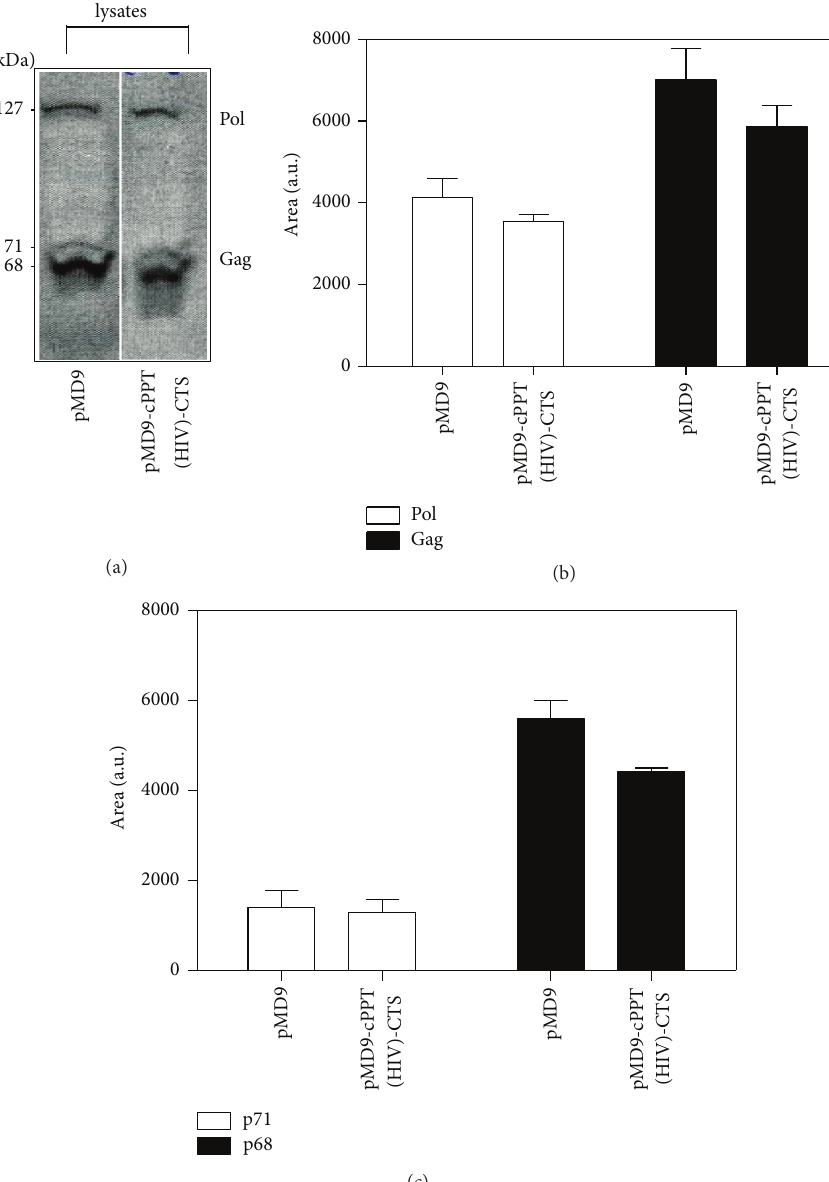
many unique functions not found for the corresponding orthoretroviral proteins. The FV structural proteins, Gag, Prt-RT, and Env are initially translated in polyprotein forms that are subsequently cleaved by cellular proteases (Gag and Prt-RT proteins), while Env polyprotein is cleaved by viral protease [15]. Interestingly, the protein analysis of the pMD9- cPPT (HIV)-CTS plasmid compared to its parental form indicated that the A549 transduction for the modified vector was reduced when judged by the Gag/Pol decrease in the HEK 293T cellular lysates (Figures 5(a) and 5(b)). However, this was offset by a significant increase in the capacity to